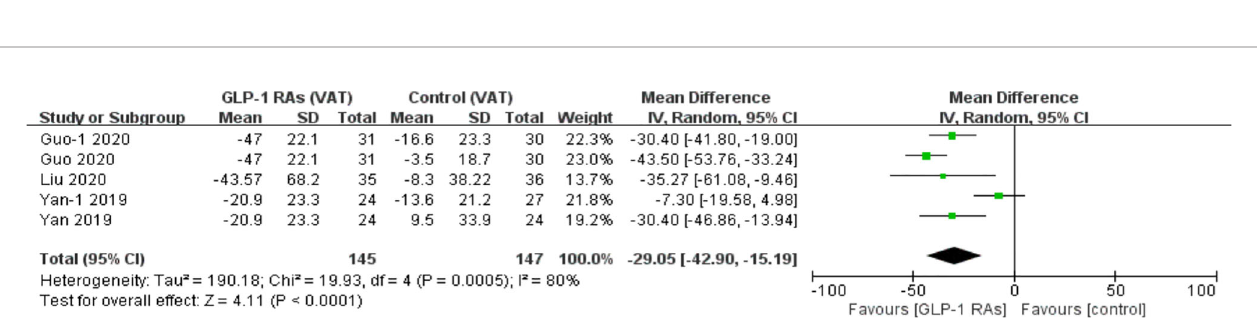
FIGURE 6 | Glucagon-like peptide-1 receptor agonists (GLP-lRAs); visceral fat (VAT); SD, standard deviation; CI, con fi dence interval; IV, inverse variance; Guo-l, concluded liraglutide vs insulin; Yan-1, concluded liraglutide vs sitagliptin.